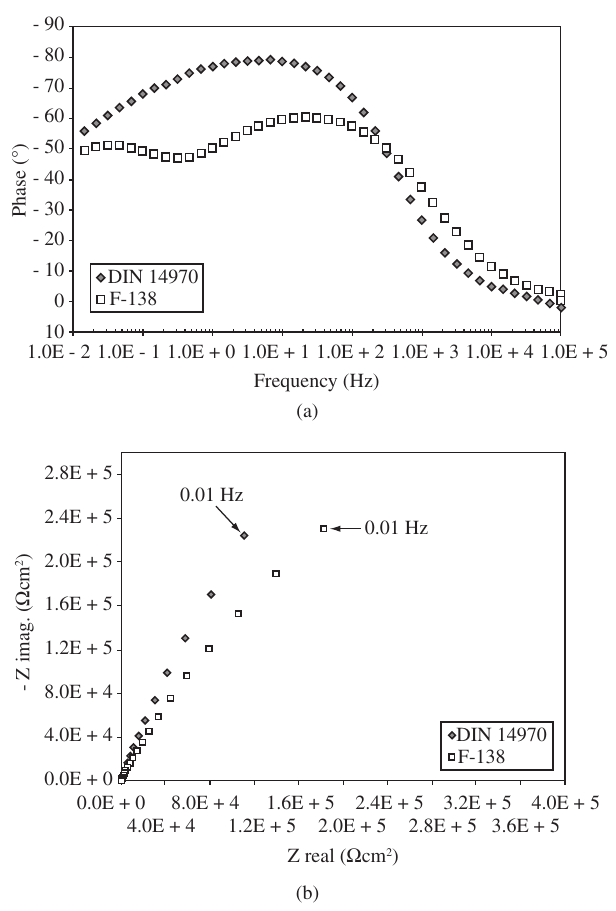
Figure 3. Equivalent circuit used to fit the impedance data for ASTM F-138 and DIN W. Nr. 1.4970 in PBS solution at room